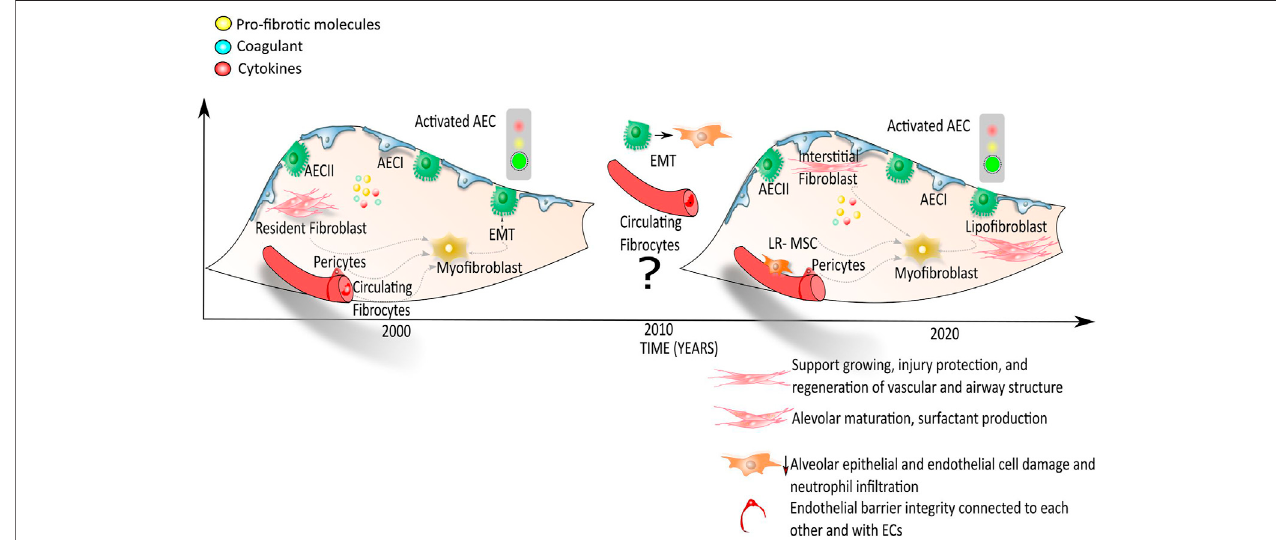
FIGURE2| OnsetandprogressionofIPF:themyo fi broblastinfocus.Accordingtothe fi rsthypothesis,theactivationofalveolarepithelialcells(AECs)leadstothesecretionof pro- fi broticmolecules,coagulantandcytokinesthatactivateseveralcellsfromdifferentsources:theresident fi broblast,theresidentmesenchymalstromal/stemcells,theepithelial cells that undergo to the epithelial mesenchymal transition, the pericytes and the endothelial cells progenitors. These different cell types in IPF lungs may differentiate into myo fi broblasts with the consequent secretion and deposition of extracellular matrix proteins followed by an overall lung structural rigidity and decline of alveolar function. Accordingtothemostrecentpublications(Etc2019;Xieetal., 2016),interstitiallung fi broblasts,pericytes,lipo fi broblasts,mesothelialcellsandLR-MSCs, whoseroleswithinthe alveolar lung niche are list in the legend within the fi gure, give rise to the myo fi broblast population representing the key cells for the onset and progression of fi brosis.